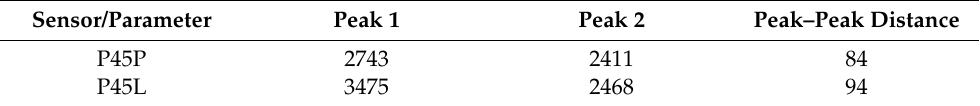
Figure 25. Example of piezoelectric sensor signals for the twin wheel for trajectory changes for a five-axle vehicle. Table 15. Piezoelectric sensor signal characteristics—amplitude (ADU) and Peak–Peak separation distance (samples) for a twin wheel.